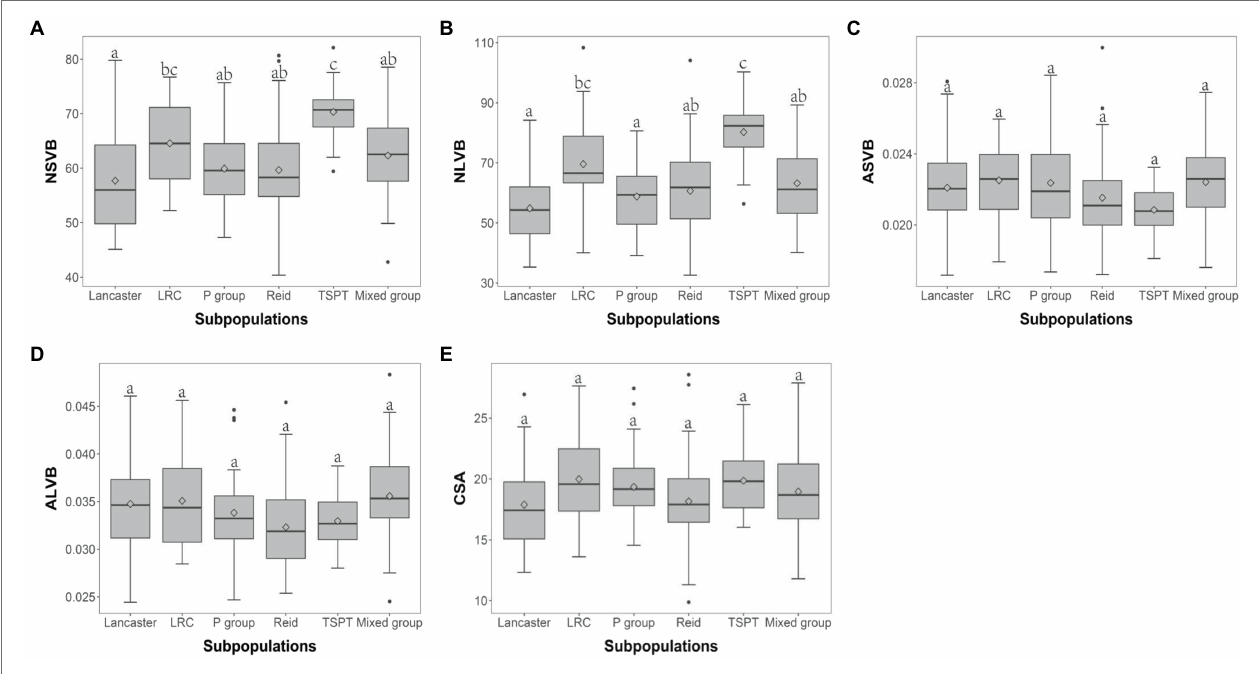
FIGURE 3 | Boxplot of vascular bundle-related traits distribution in different subpopulations. ANOVA was applied to examine the difference of traits among subpopulations. Different numbers indicate significant difference at p ≤ 0.05. (A) NSVB; (B) NLVB; (C) ASVB; (D) ALVB; and (E)